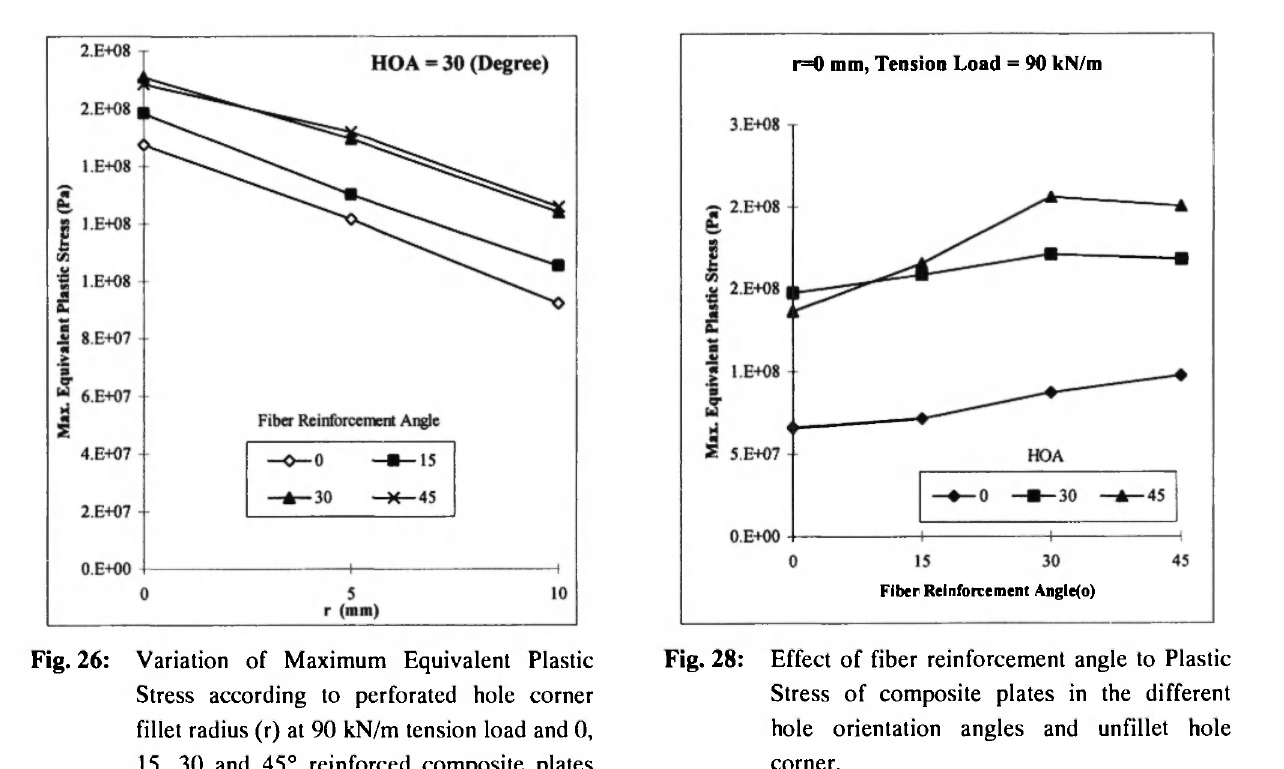
Fig. 26: Variation of Maximum Equivalent Plastic Stress according to perforated hole corner fillet radius (r) at 90 kN/m tension load and 0, 15, 30 and 45° reinforced composite plates and 30° oriented hole.